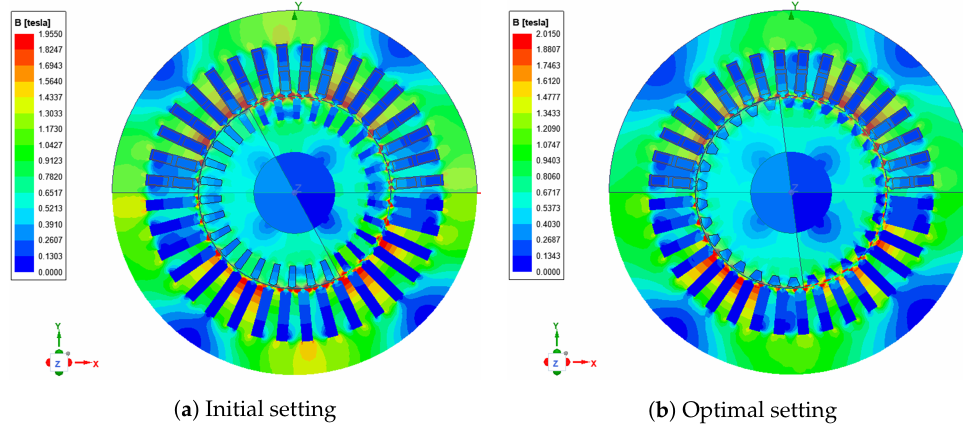
Figure 7. Magnetic flux density distribution in the investigated